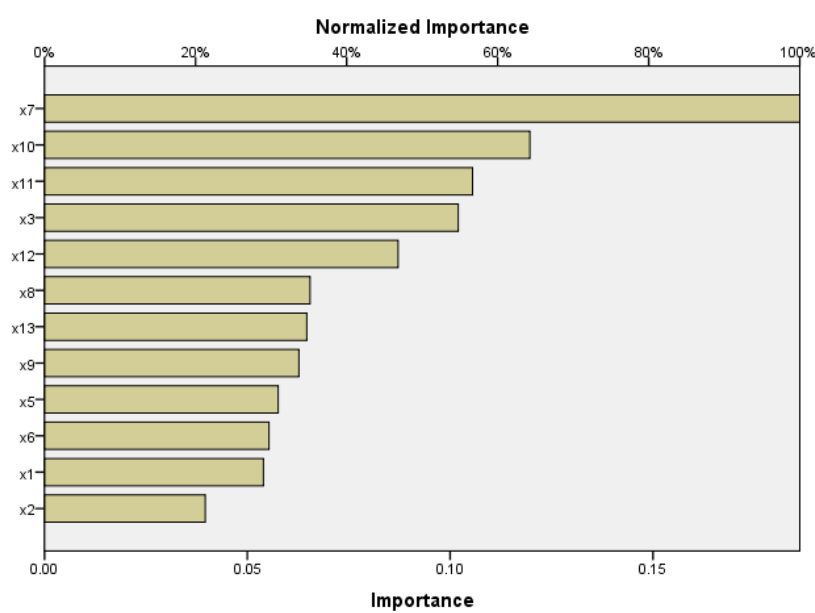
Fig. 5: ROC curve for the categories of the tumor.